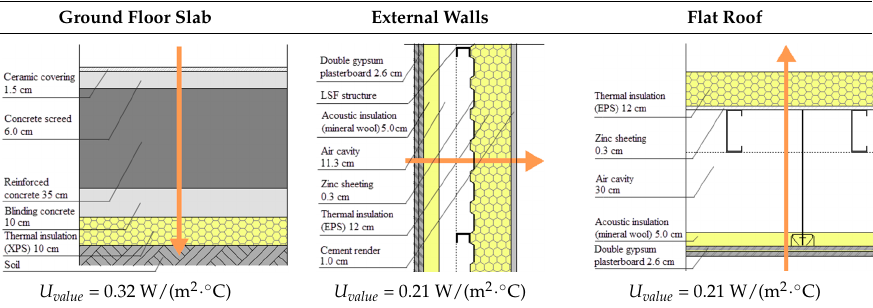
Table 1. Constructive solutions of the opaque building envelope.